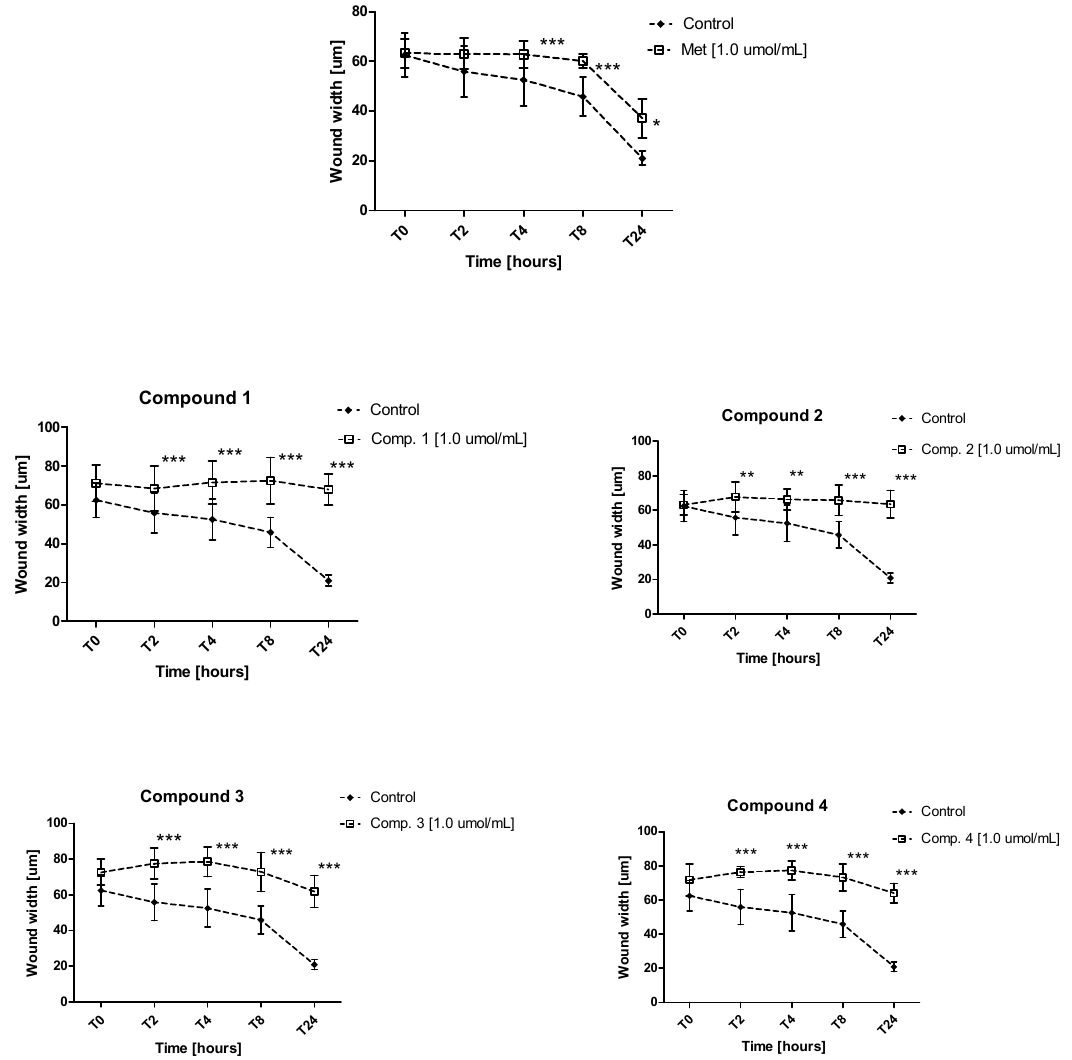
Figure 4. Inhibition of cell migration in the presence of biguanides. AoSMC cell migration was evaluated using wound healing assay. Graphs depict the changes of wound width [ µ m] during 24 h in the absence (control) and in the presence of examined compounds at 1.0 µ mol / mL. The results are presented as mean ± SD ( n = 6–10). * p < 0.05; ** p < 0.01; *** p < 0.001 compared with control. Two-way Anova analysis exhibited more profound effects of compounds 1 and 2 on AoSMC cell migration than compounds 3 and 4 .